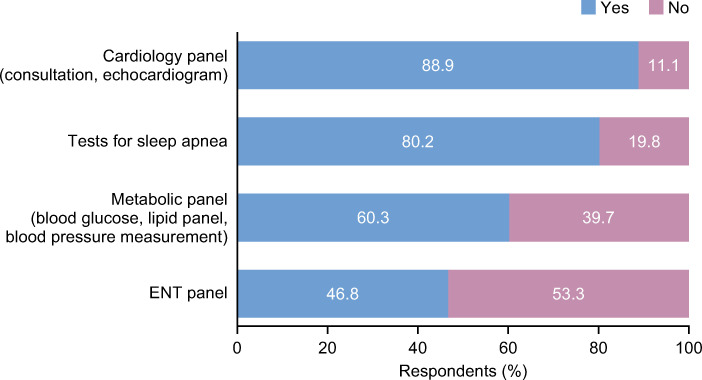
Comorbidity assessments implemented as secondary prevention measures in the outpatient settinga.aSimilar values were reported for hospital assessments. ENT; ear, nose and throat.